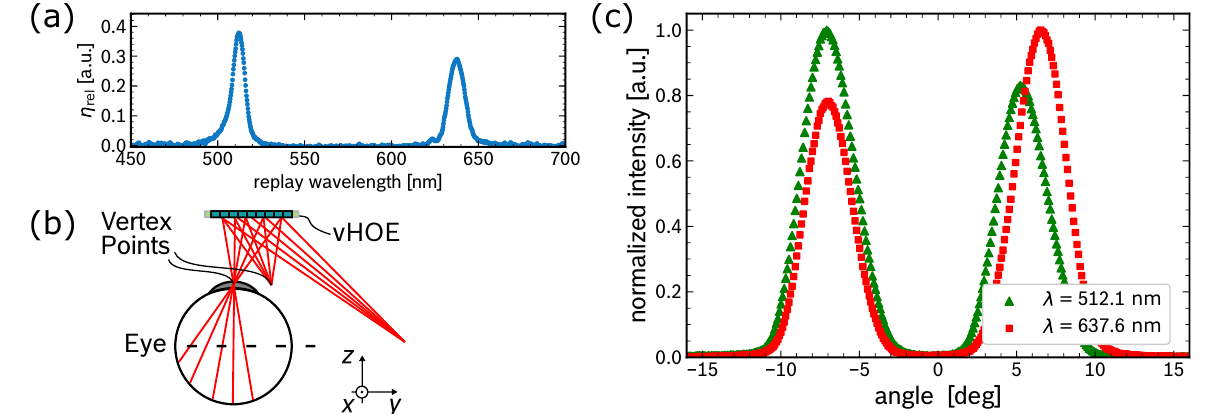
Figure 10. ( a ) Relative diffraction efficiency η rel ( λ ) of the multiplexed vHOE for a fixed incidence angle at ϑ = 45°. ( b ) Schematic of the vHOE’s global optical function with two vertex points. ( c ) Normalized chromatic intensity of the multiplexed vHOE measured at various angles of diffraction in the same half-sphere as the optical source. During the measurement, the optical source is positioned with a fixed incidence angle to the vHOE corresponding to the recording configuration.